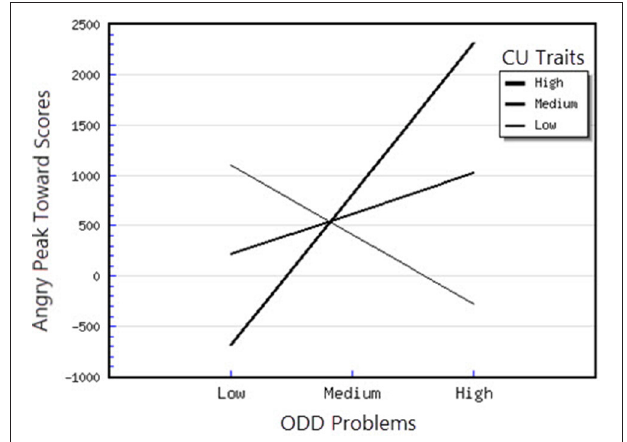
FIGURE 3 | Interaction between ODD problems and CU traits in predicting angry peak toward scores.